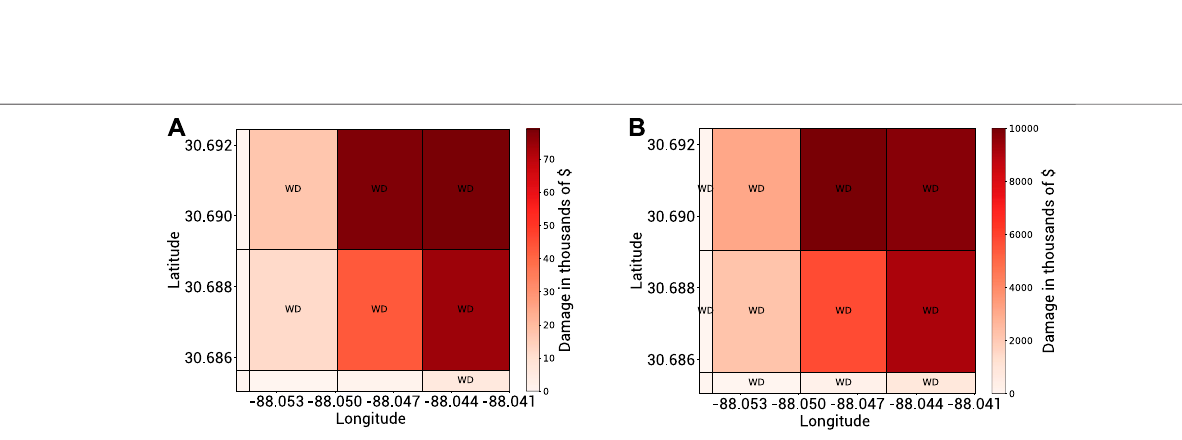
FIGURE 14 | (A) Community layout with respect to different identi fi ed cells. (B) Cell identi fi er and number of houses in each cell.